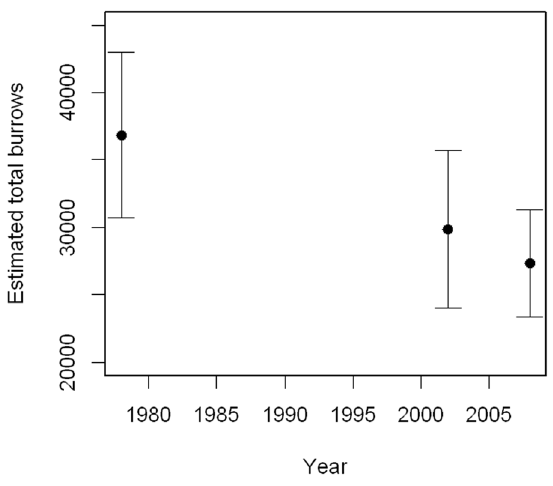
Figure 3. Changes in total burrows. Estimated total number of burrows on Lord Howe Island in 1978/9, 2002/3 [10] and 2008/9.